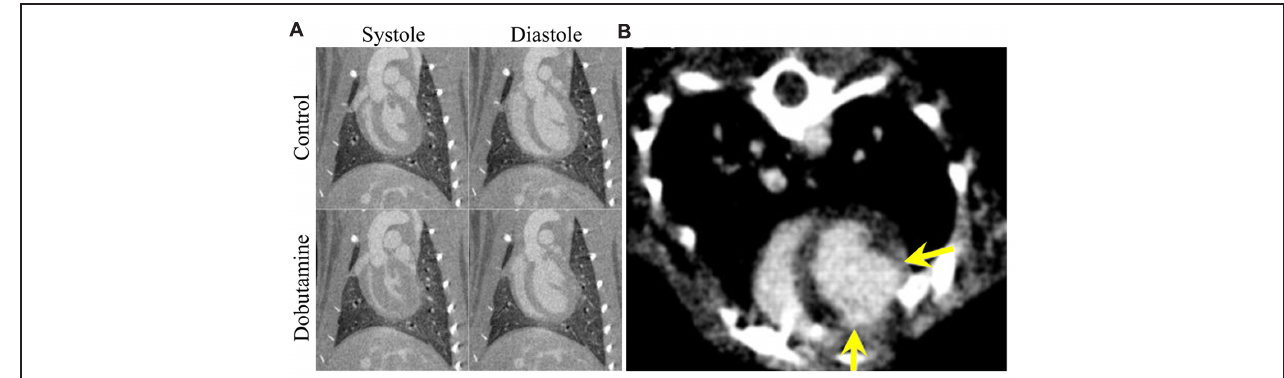
FIGURE 7 | Cardiac micro-CT imaging. (A) Coronal micro-CT images through the left ventricle of a rat showing the heart in systole (left) and diastole (right) with and without the administration of dobutamine (10 µ g/kg/min). End systolic volume is significantly decreased and stroke volume and cardiac output are both significantly increased. End diastolic volume is relatively unchanged after administration of dobutamine. (B) An axial image showing myocardial infarction in a rat using delayed hyper enhancement. The yellow arrows show the boundaries of the region of myocardial infarction.